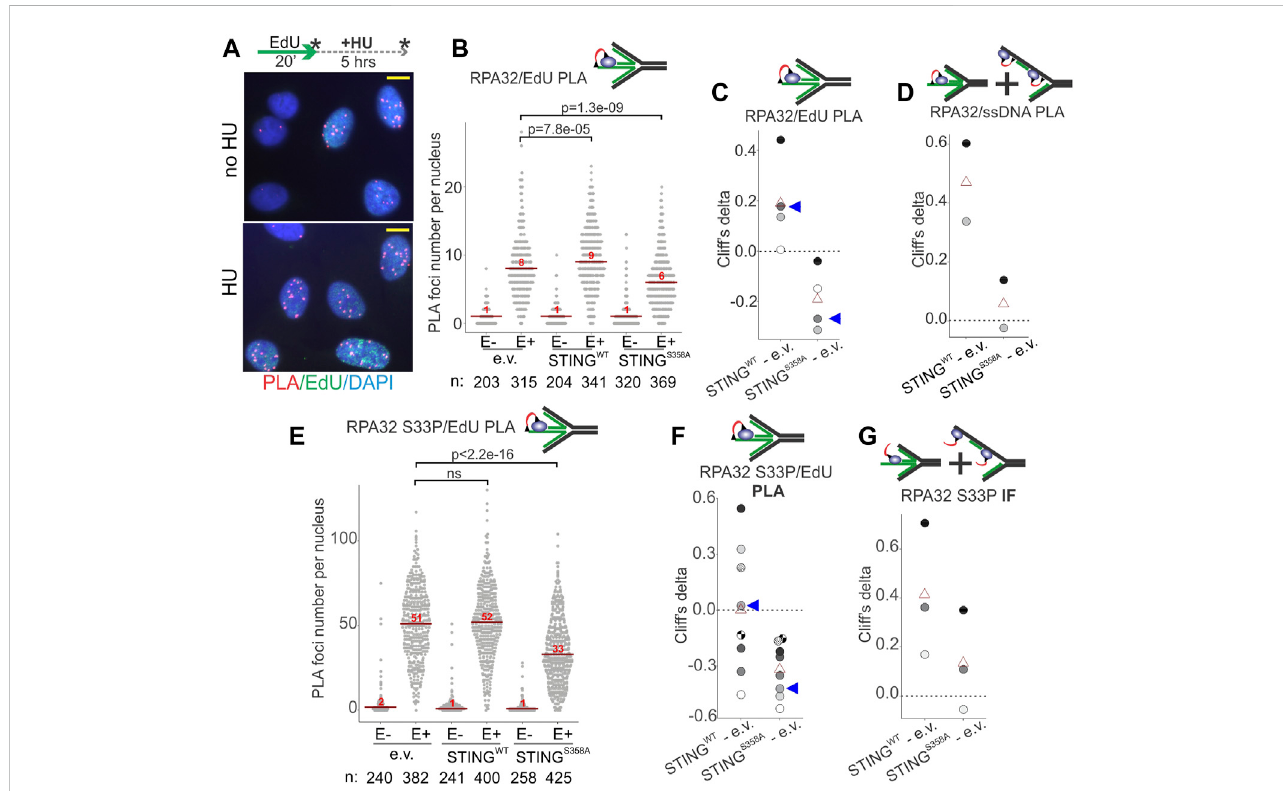
FIGURE 6 STING affects the levels of RPA on parental and nascent DNA in HU-treated cells. (A) Examples of RPA32 to EdU PLA fl uorescence in the control U2OS cells, treated as shown. Cells were labeled with EdU and harvested immediately or after a 5 h HU arrest, as shown by asterisks. Scale bar = 10 μ m. (B) A schematic of the likely substrate for the RPA32/EdU PLA (red arc represents fl uorescent signal) and representative distributions of RPA32/EdU PLA foci numbers in the U2OS cells with empty vector (e.v.) or the indicated STING transgenes. Cells were labeled as in (A) and EdU was Clicked to a mixture of biotin and Alexa488 azides at a molar ratio of 50:1 to enable simultaneous visualization of EdU-positive cells and PLA signals. PLA foci numbers are shown separately for EdU-negative (E − ) and EdU-positive (E+) cells. Red lines are medians and their values are shown above the lines. p values were calculated in Wilcoxontests. (C) MagnitudesofdifferencesbetweenRPA32/EdUPLAfocidistributionsinSTINGWTvs.controlandSTINGS358Avs.controlwerecalculated asCliff ’ sdeltavaluesandplotted.ShownareCliff ’ sdeltavaluesforeachoffourindependent experimentsperformedandquanti fi edasin (B) .Eachexperiment is identi fi able by fi ll tone of the circle symbols. Red triangles are means. Blue arrowheads identify the values derived from the experiment shown in (B) . (D) Cliff ’ s delta values for two biological replicates of an experiment performed as in (B) and measuring RPA32/ssDNA PLA foci numbers. Likely substrates for the RPA32/ssDNA PLA are shown above the plot. (E) Distributions of RPA32 S33P/EdU PLA foci numbers in the U2OS cells with empty vector or the indicated STING transgenes. Cells were labeled with EdU and treated with HU as in (A) . All samples are HU-treated. PLA foci numbers are shown separately for EdU- negative(E − )andEdU-positive(E+)cells.Redlinesaremediansandtheirvaluesareshownabovethelines. p valueswerecalculatedinWilcoxontests. (F) Cliff ’ s delta values calculated for RPA32 S33P/EdU PLA foci distributions in STING WT vs. control and STING S358A vs. control pairs in each of eight independent experiments performed and quanti fi ed as in (E) and identi fi able by fi ll tone or fi ll pattern of the circle symbols. Triangle symbols are means. Blue arrowheads identifythevaluesfromtheexperimentshownin (E) . (G) Cliff ’ sdeltavaluescalculatedfordifferencesofdistributionsofmean fl uorescenceintensities(MFI)per nucleus measured by IF in situ for RPA32 S33P in STING WT vs. control and STING S358A vs. control cells. MFI values were measured in EdU-positive, HU- arrested cells in three independent experiments. For all Cliff ’ s delta values, positive values mean that the values of the fi rst distribution in the comparison (e.g., STING WT in the STING WT — e.v. comparison) are overall higher than those of the second distribution, and negative values mean that the reverse is true. Distribution medians are displayed as in (E)